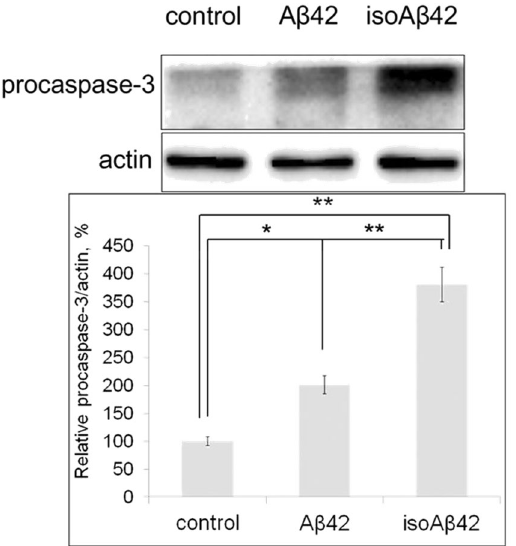
Figure 2. Effects of A β 42 and isoA β 42 (10 μ M, 6 h) treatment on procaspase 3 levels in SH-SY5Y cells. After peptide treatment, the cells were lysed, the isolated proteins were separated by SDS-PAGE, caspase 3 and actin were detected by Western blot using the appropriate antibodies. The bars represent procaspase 3 expression changes. Each value represents the mean ± SD of at least three independent experiments; * p < 0.02, ** p < 0.005. Here and on the other figures full-length gels and blots are included in a Supplementary